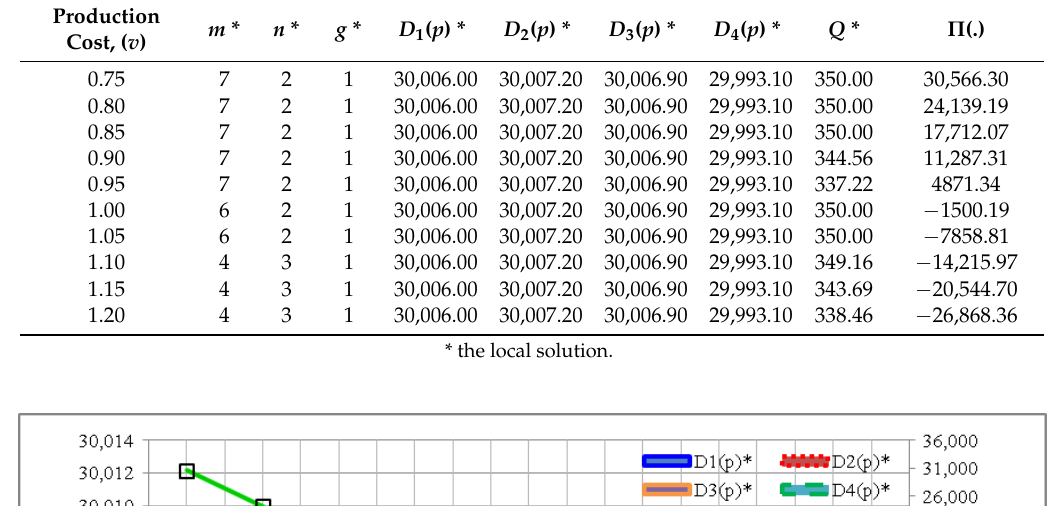
Table 9. Effect of Changes in the Production Cost Parameter.